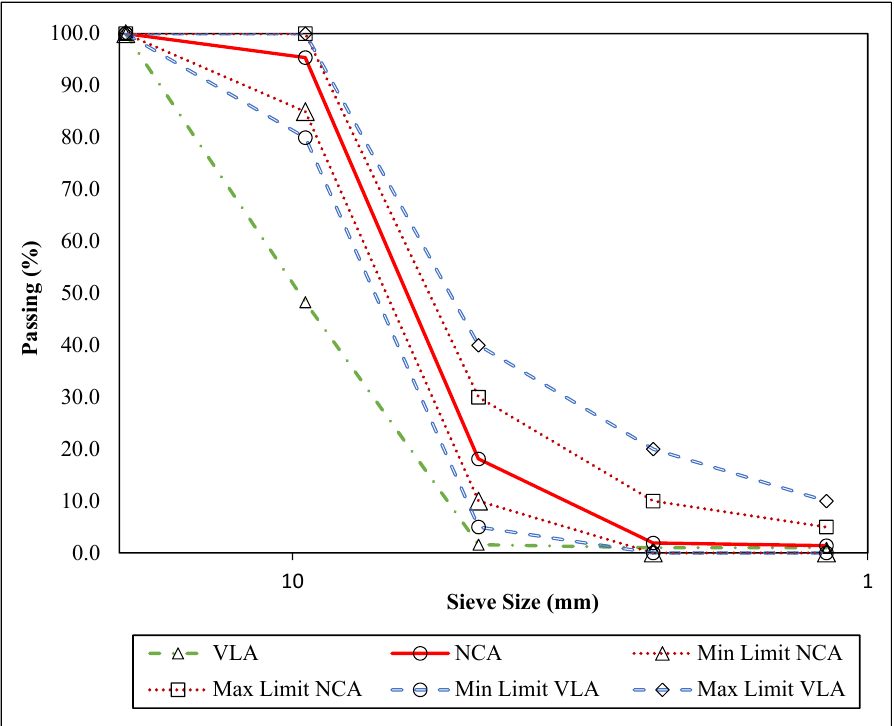
Figure 1. Reference coarse aggregates used: normal weight coarse aggregate (NCA) ( a ); volcanic lightweight coarse aggre- gate (VLA) ( b ) and lytag coarse aggregate (LYA) ( c ).